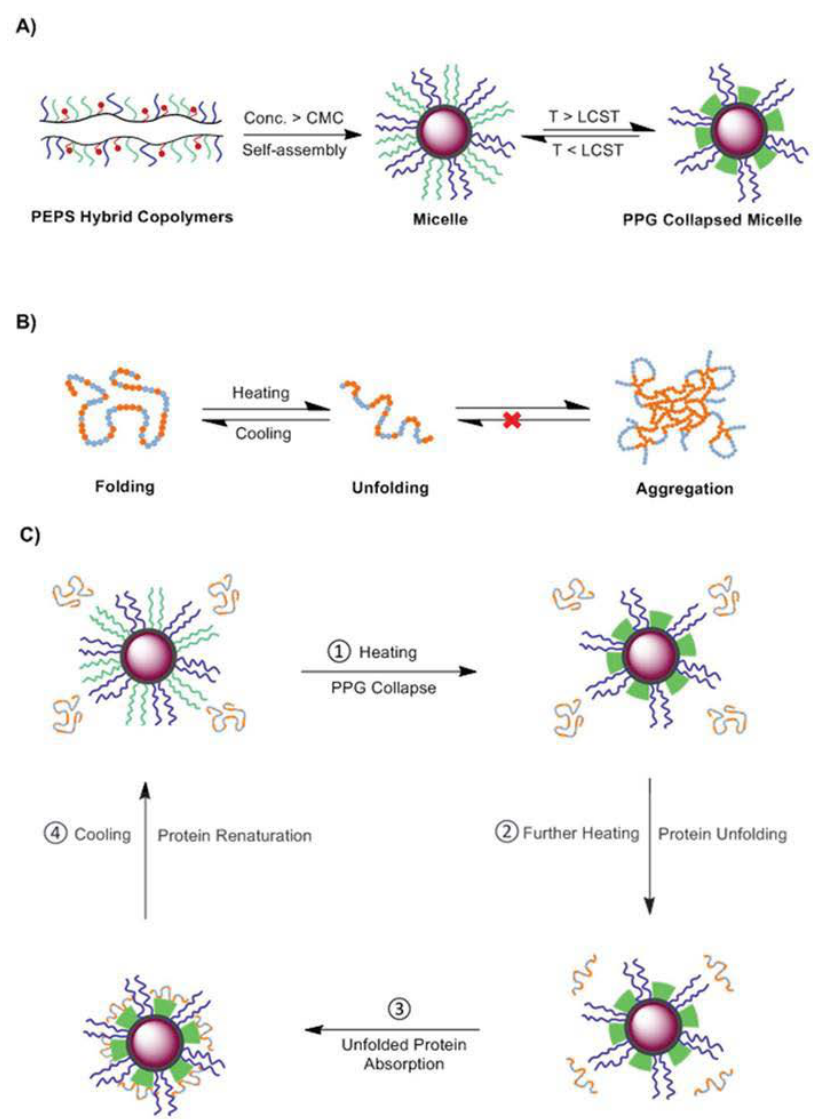
Figure 4. Schematic representation of ( A ) thermoresponsive poly(PEGMA-PPGMA-POSSMA) (PEPS) hybrid copolymer self-assembly in aqueous solution and ( B ) heat-induced protein denaturation process. Yellow and light blue spots represent the hydrophobic and hydrophilic sites of proteins, respectively. ( C ) Proposed working mechanism of the thermally denatured protein protection by thermoresponsive PEPS hybrid micelles. LCST, CMC and PPG represents for lower critical solution temperature, critical micelle concentration and poly(propylene glycol), respectively. Reprinted with permission from [67]. Copyright (2014) The Royal Society of